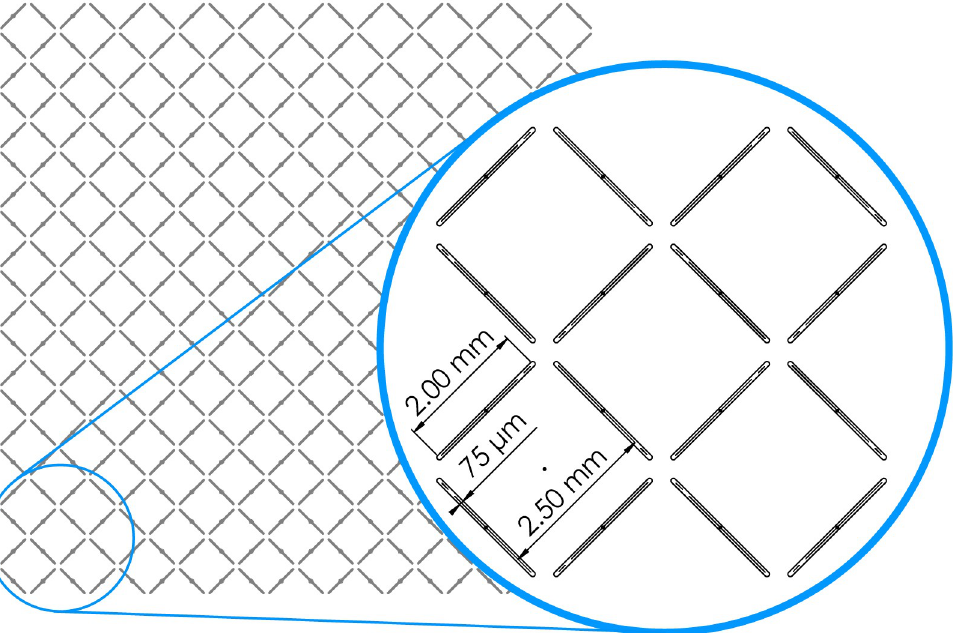
Fig 2. Cross-hatch pattern for perforating negshell cores. The cross-hatch are 75 wide by 2 mm long slots oriented in a 2.5 mm by 2.5 mm square pattern. The slots are designed to be small enough to be partially fused during printing to keep geometric integrity but also become fragile under